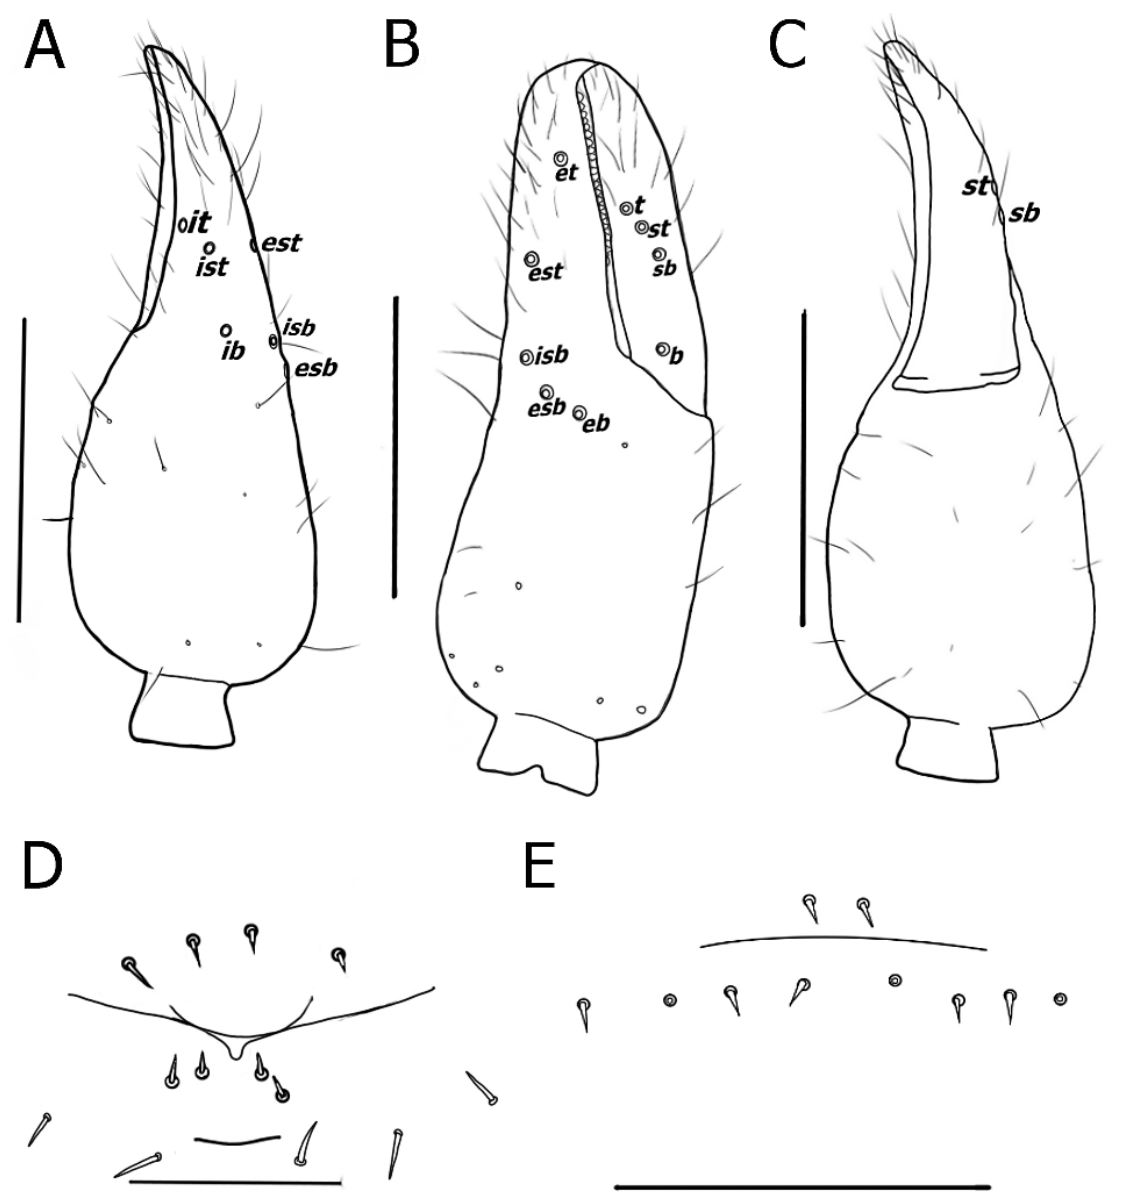
Fig. 24. Ideoblothrus nadineae sp. nov. A . Chela in dorsal view, showing trichobothria. B . Chela in retrolateral view. C . Chela in ventral view. D . Outer genital area. E . Genital area. A–D: holotype, ♂ (QCAZ); E: allotype, ♀ (QCAZ). Scale bars: A–C, E = 0.25 mm; D = 100